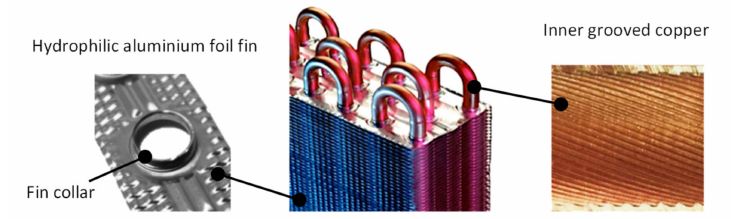
Figure 1. Air heat exchanger, comprising inner grooved copper tubes and hydrophilic aluminium foil